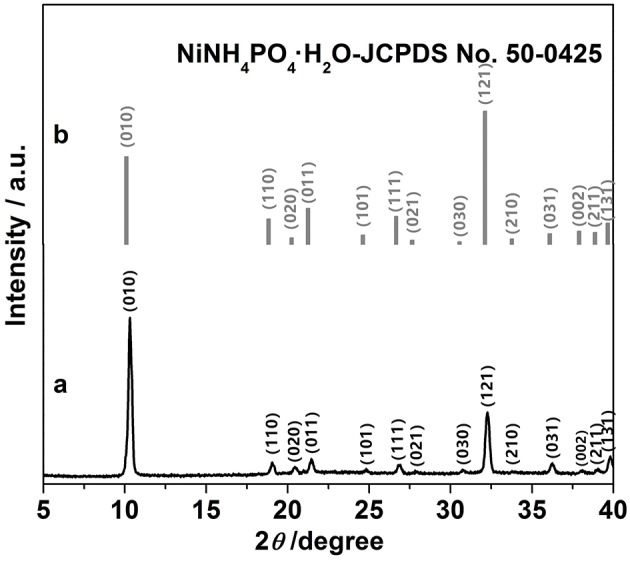
(a) X-ray diffraction patterns of as-prepared NH4NiPO4·H2O samples and (b) corresponding JCPDS No. 50-0425.